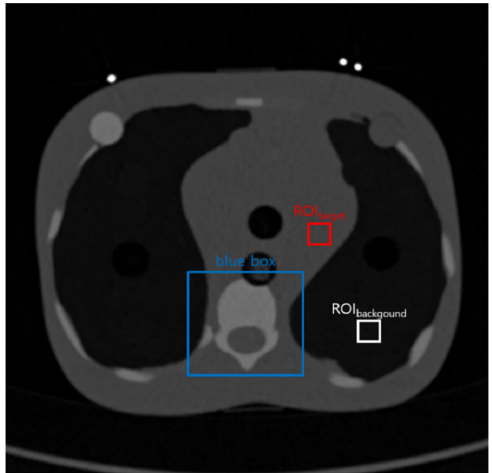
Figure 2. The image obtained from a 5-year-old phantom. The region inside the blue box was magnified to compare the denoised images. ROIs were set to calculate the coe ffi cient of variation (COV) and contrast-to-noise ratio (CNR) of the chest